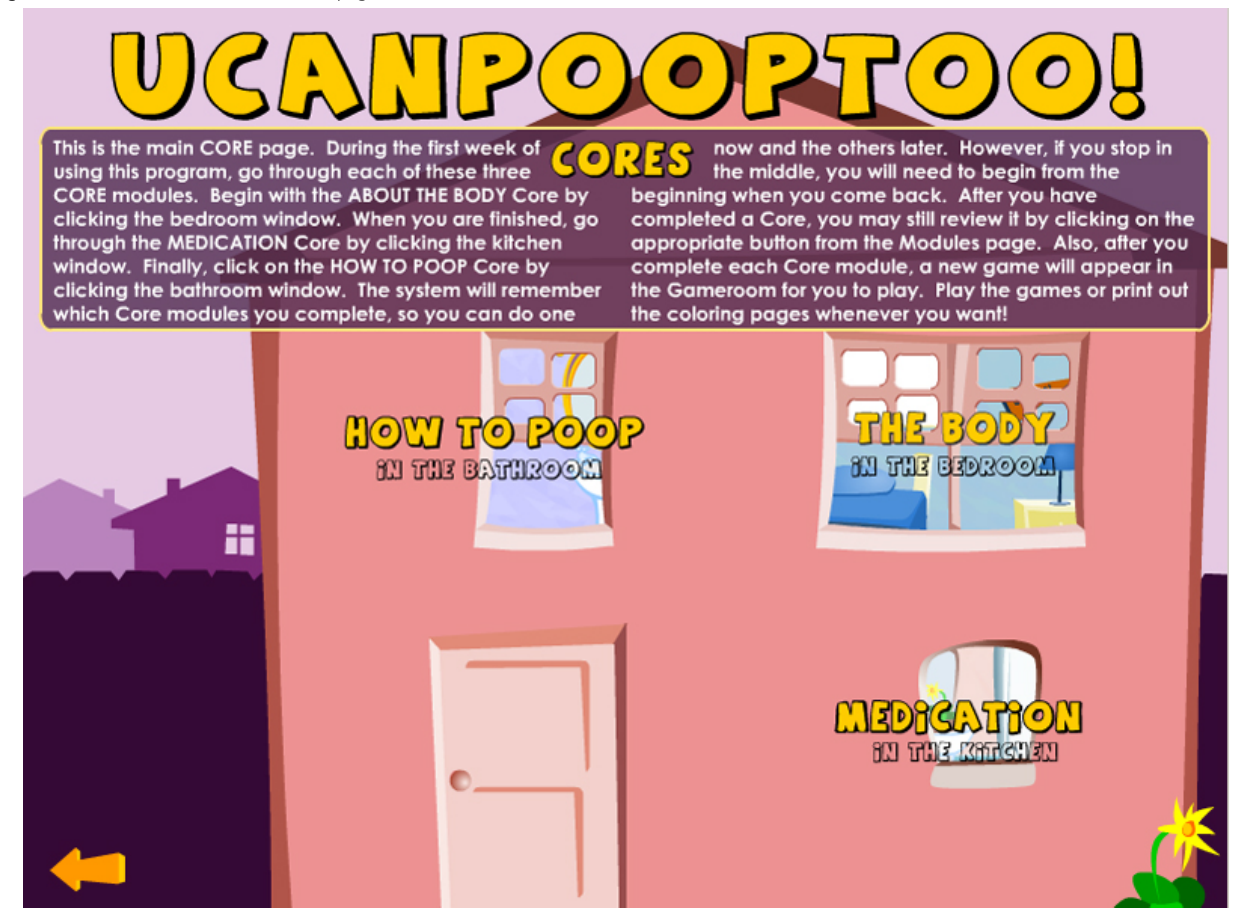
Figure 2. Screenshot of the “Welcome” page of